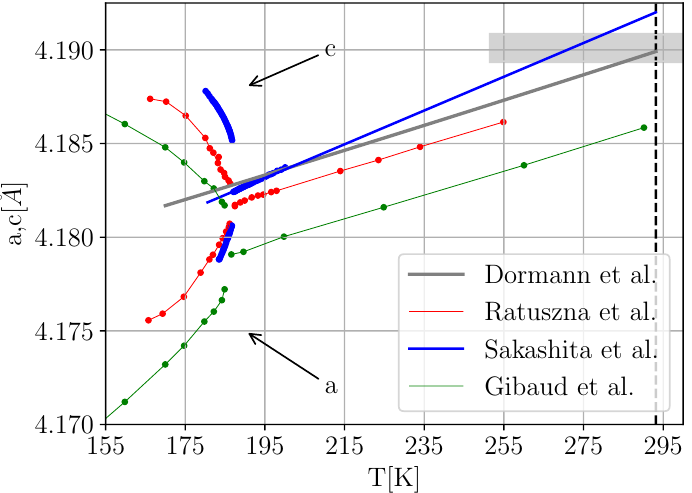
Figure 1. Compilation of experimental unit cell data from Refs. [15] (red) and [18] (green) (data range restricted to T > 155 K ) [16,17] (blue) and [14] (gray). For comparison, the value (including error bars) of the room temperature (indicated by the vertical dashed line) lattice constant at ambient pressure as measured in Ref. [11] is illustrated by the gray horizontal area.